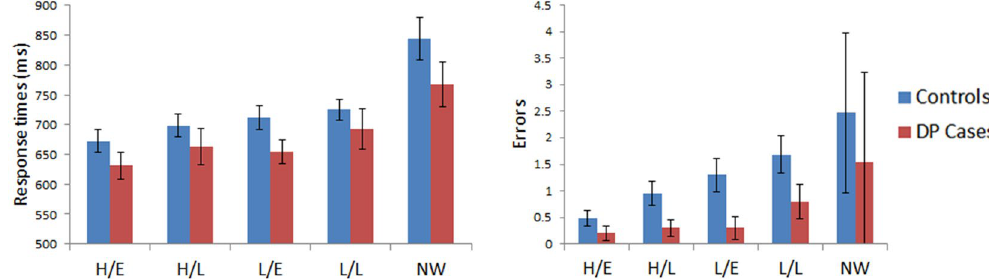
Figure 6. Results for Lexical Decision: Frequency x AoA. Data for words and non-words (NW) are shown in left panel (response time) and right panel (number of errors) for control and DP groups. Error bars indicate ± SEM. The four word conditions are high frequency/early acquisition (H/E), high frequency/late acquisition (H/L), low frequency/early acquisition (L/E), and low frequency/late acquisition (L/L). As there were 4 times more items in the NW condition, the NW errors were divided by 4 to make their rates displayed in the graph proportionally comparable to the word conditions.